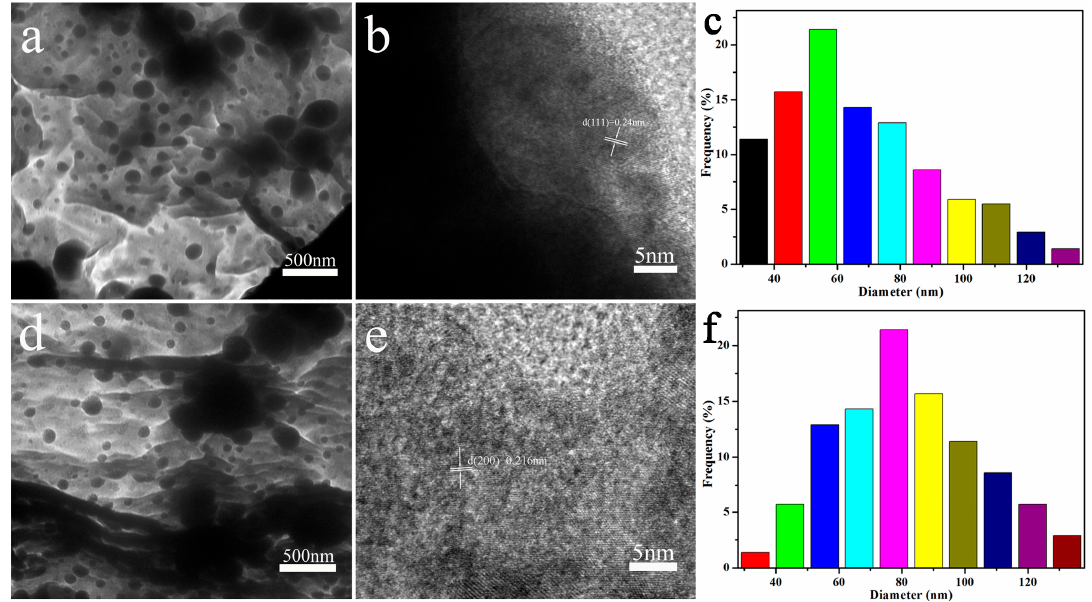
Figure 3. TEM images of the prepared MXene@PdNPs5 and MXene@PdNPs20 samples at 5, 20 min ( a,d ) and high-resolution TEM images of Pd nanoparticles ( b , e ), respectively and ( c , f ) Particle size distribution of Pd nanoparticles.